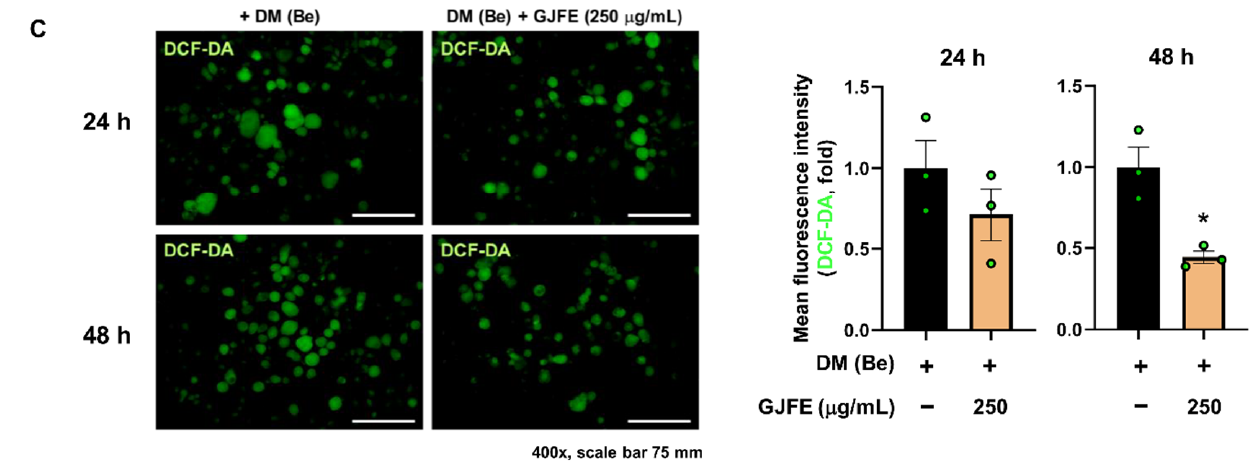
Figure 6. Effect of GJFE on oxidative stress in beige-induced 3T3-L1 cells. ( A ) Catalase activity was measured in beige-induced 3T3-L1 cells treated with GJFE (250 μg/mL). ( B ) Protein levels of NRF2 and HO-1 were analyzed by Western blot analysis. ( C ) DCF-DA staining was performed at 24 h and 48 h post GJFE treatment in beige-induced 3T3-L1 cells (magnification 400×, scale bar 75 μm). β-actin was used as a loading control for Western blot analysis. All data are expressed as the mean ± SEM of the data from three or more separate experiments. # p < 0.05 vs. DM (Be)-untreated 3T3-L1 cells, * p < 0.05 vs. DM (Be)-treated 3T3-L1 cells. GJFE, Gardenia jasminoides fruit extract.